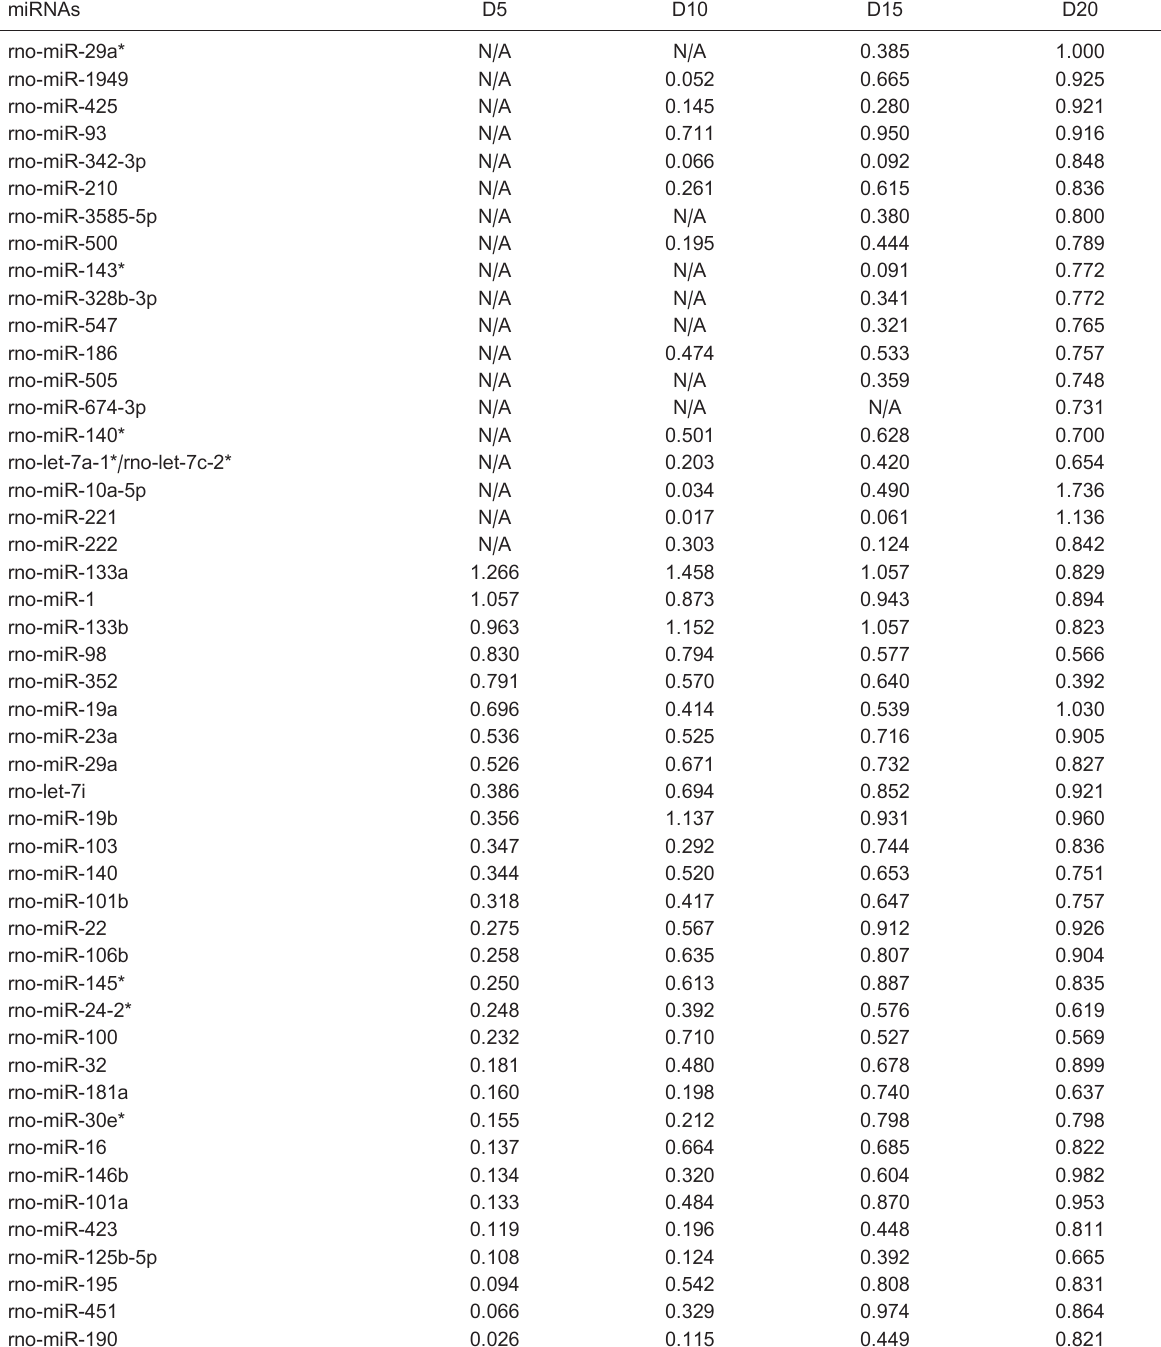
Table 2. Downregulated miRNAs during heart hypertrophy in